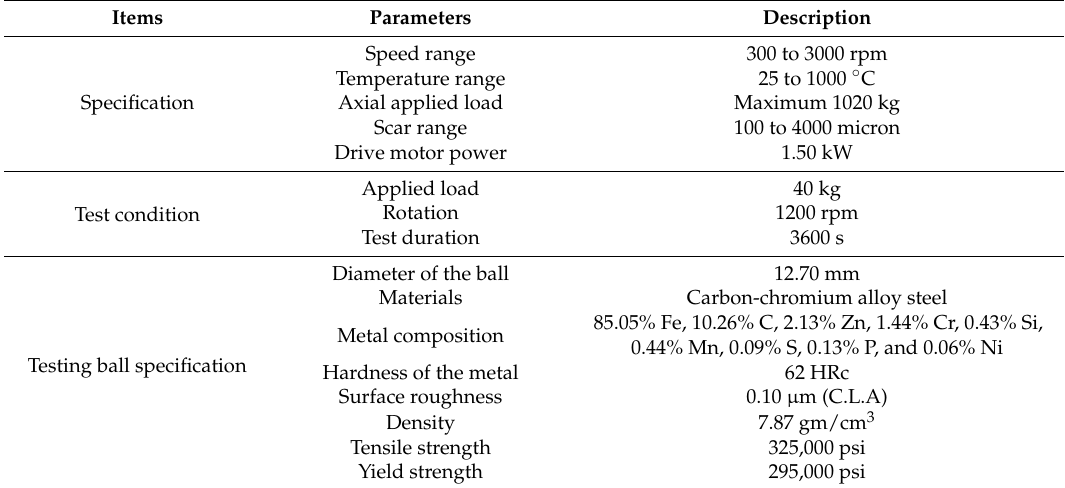
Figure 1. Schematic diagram of four-ball tribotester (TR-30H). Table 1. Setup specification and experimental test condition.